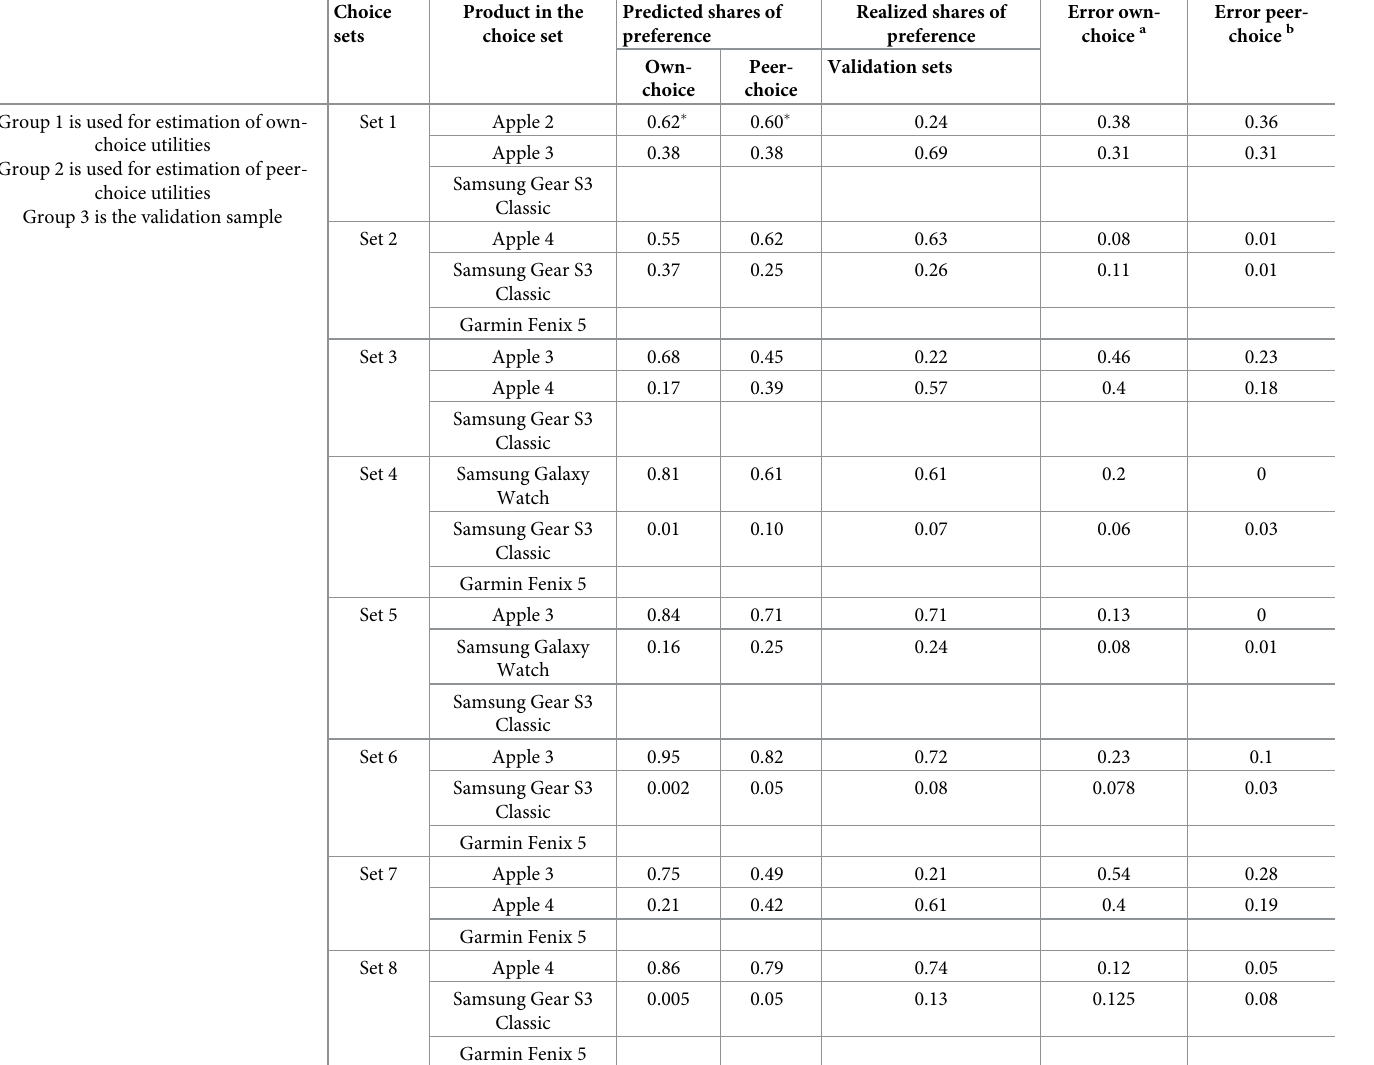
Table 2. Prediction errors: The own-choice model and the peer-choice model (experiment